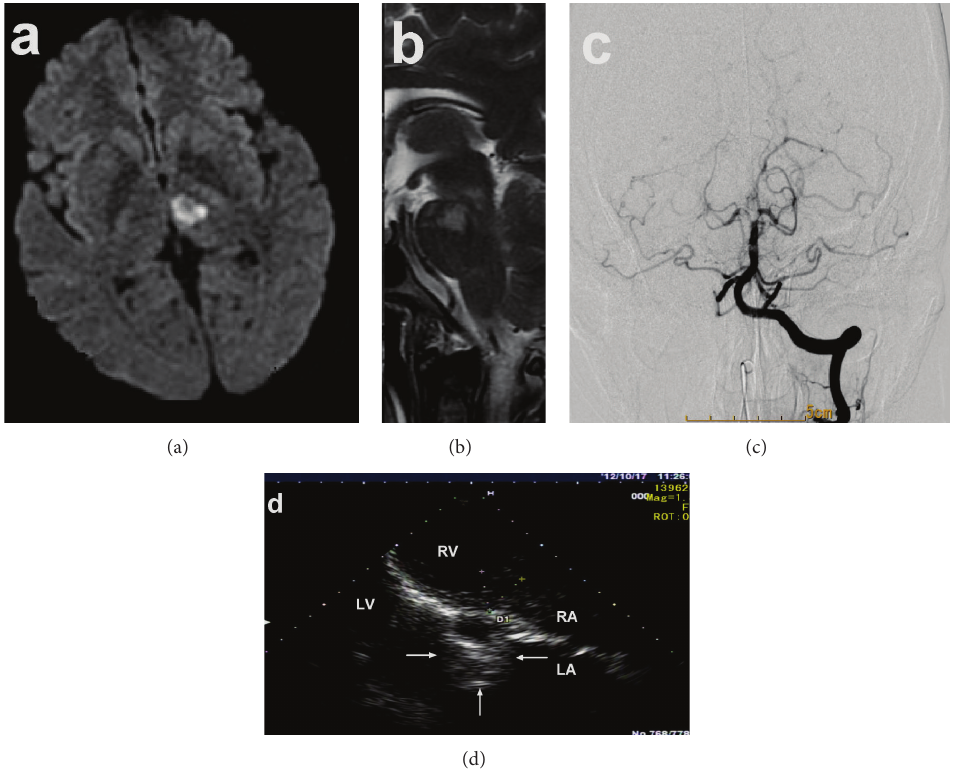
Figure1:ApatientpresentedwithNMO-likeattack.A34-year-oldwomanwithbilateralimpairedvision,doublevision,quadriplegia,dysuria, and internuclear ophthalmoplegia had normal brain CT results on 14 October 2012. Brain MRI showed multiple new lesions in brain. (a) MRI revealed abnormalities beside the third ventricle. (b) MRI revealed lesions in the pons. (c) DSA revealed occlusion of the top of the basilar artery. (d) Echocardiography showed a highly mobile mass attached to the fossa ovalis of the left atrium